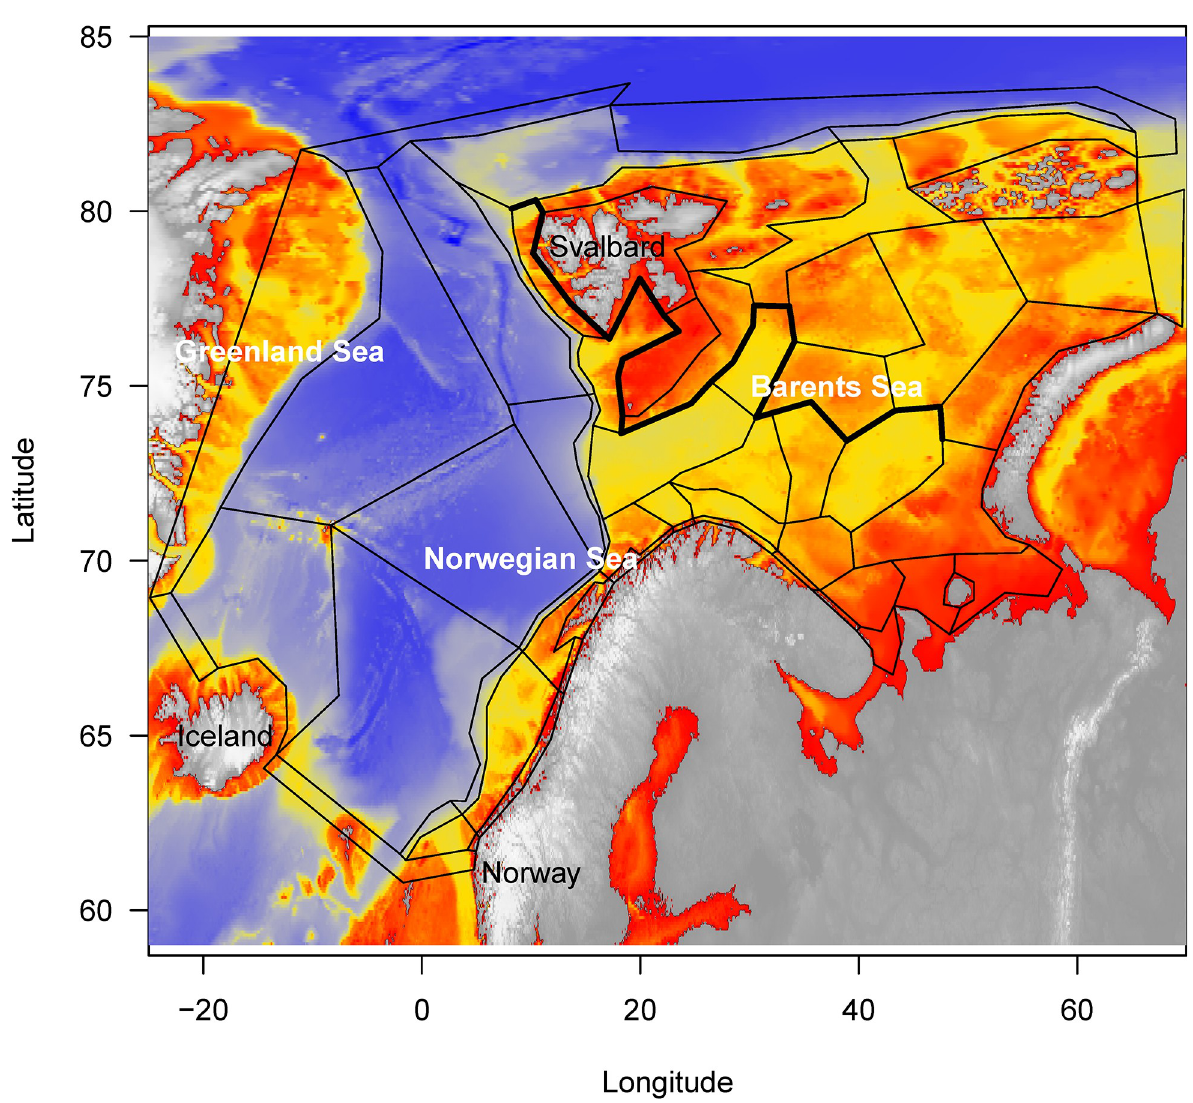
Fig 1. NoBa model domain. The model domain of the Nordic and Barents seas model, including the bathymetry.